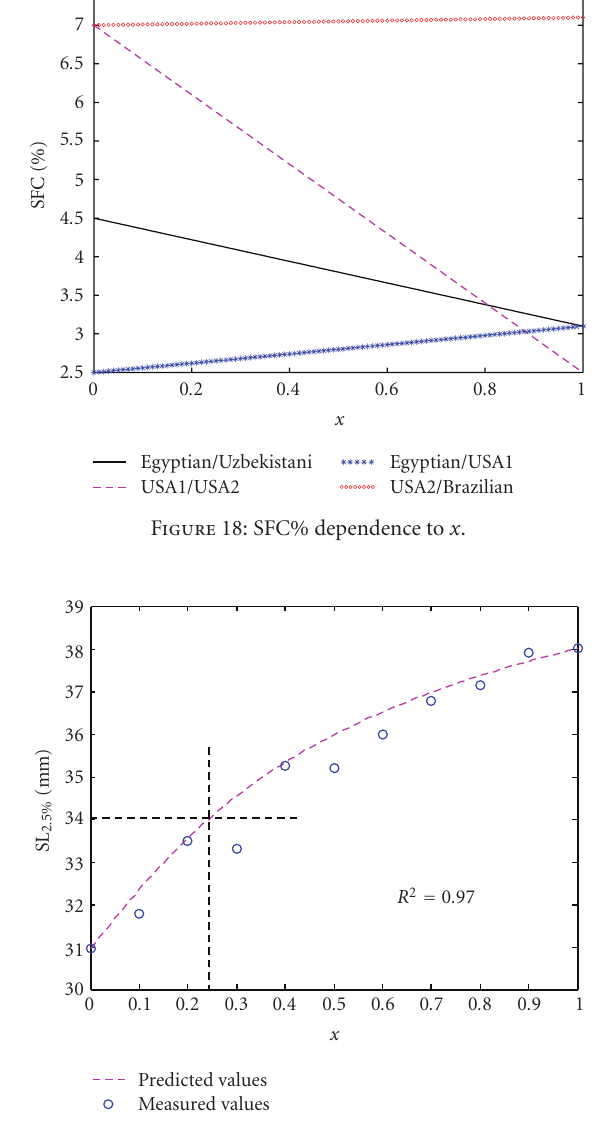
Figure 19: SL 2 . 5% values determined from established distribution functions and those of real blends.